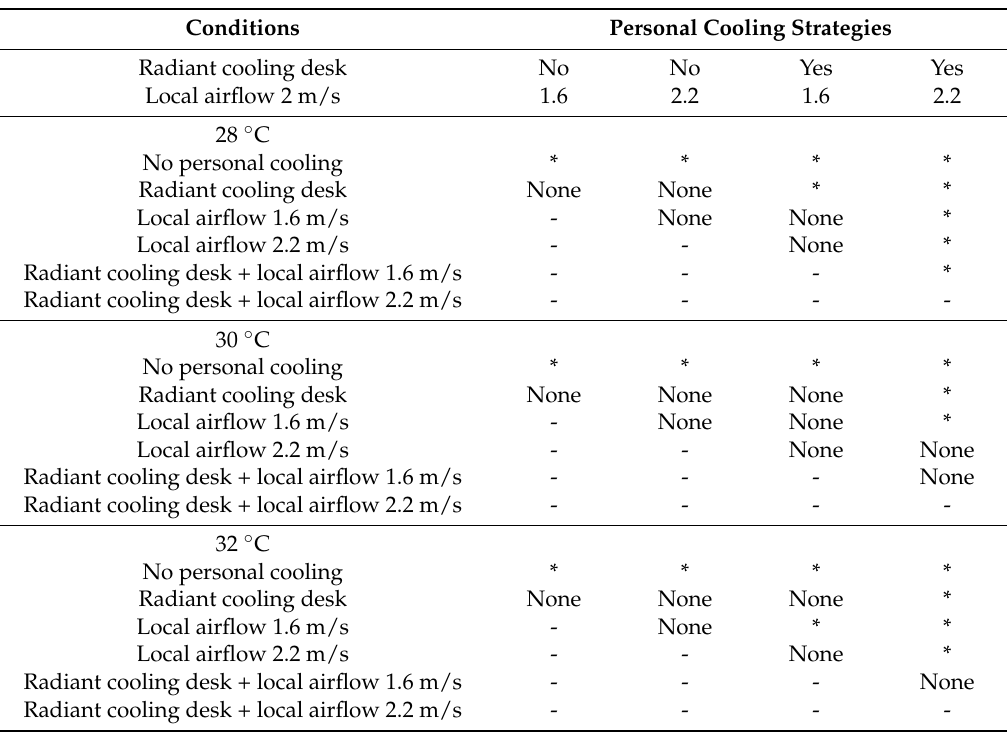
Table 6. Thermal sensation differences among personal cooling